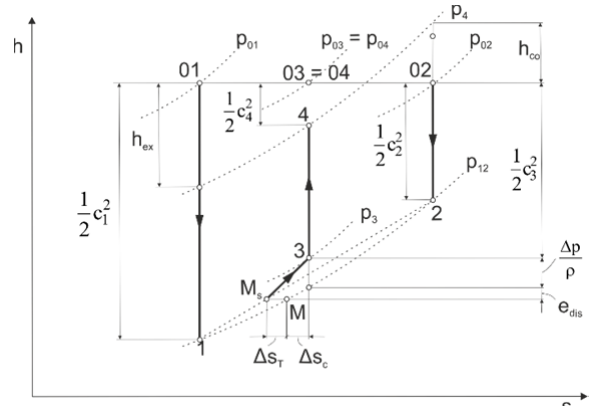
Fig. 3. Processes in an ideal ejector in the enthalpy-entropy diagram for the same total temperature of primary and secondary stream (T 01 = T 02 ).